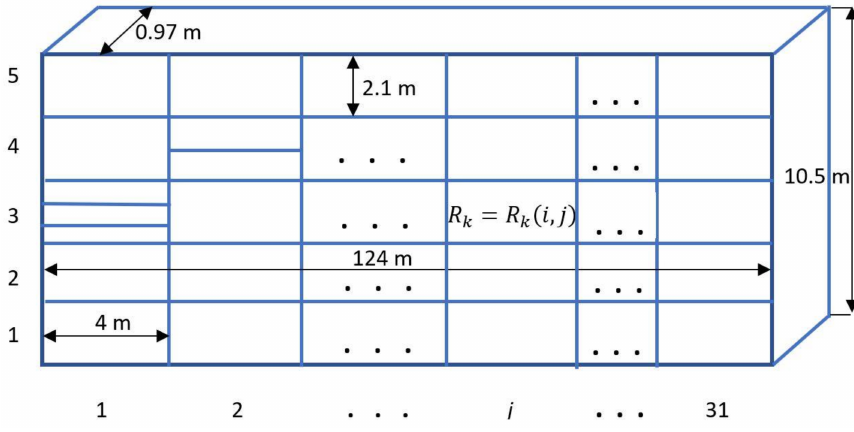
Figure 2. Shelf system details. (Source: self-edited figure).